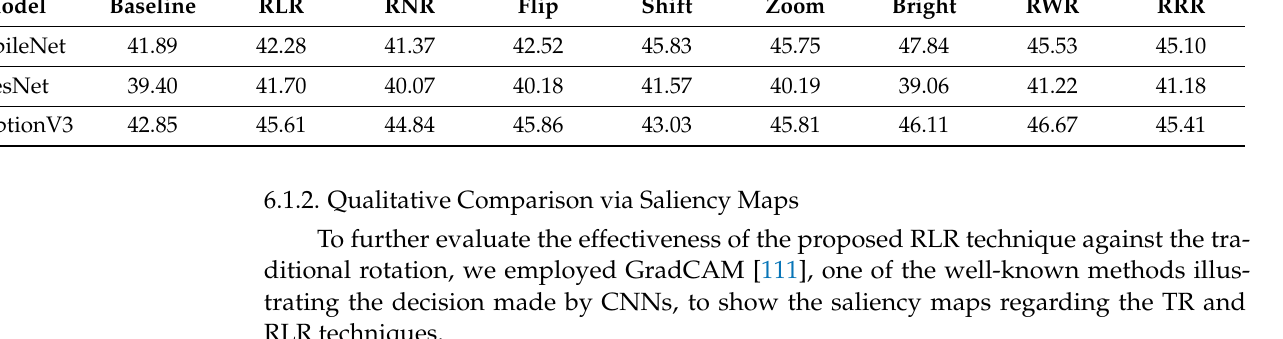
Table 4. Classification accuracy comparison between RLR and other common data augmentation techniques. CNN models, i.e., MobileNet, ResNet and InceptionV3, with the data augmentation techniques, were applied on the smallest subset of CIFAR-10 (i.e., the one with 1000 samples). Model